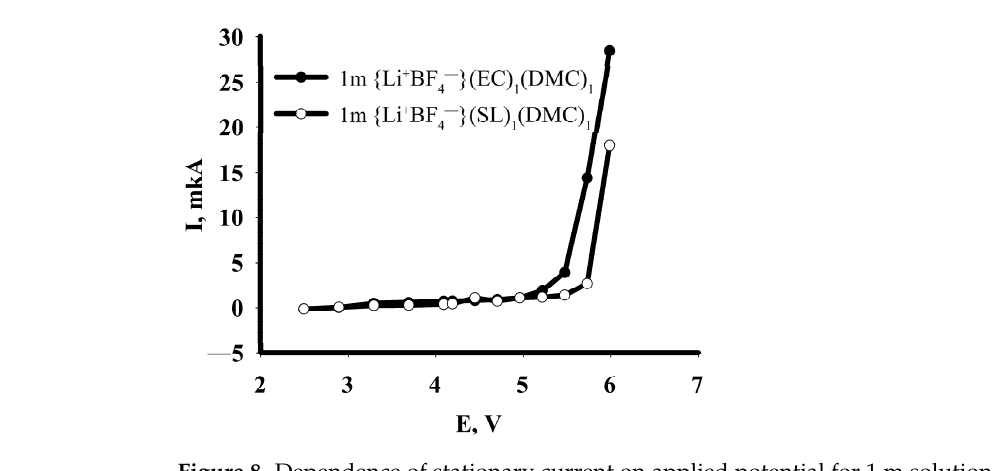
Figure 8. Dependence of stationary current on applied potential for 1 m solutions of {Li + BF 4 − } in EC/DMC (1:1, vol.) and SL/DMC (1:1, vol.); evaluation of oxidative stability .